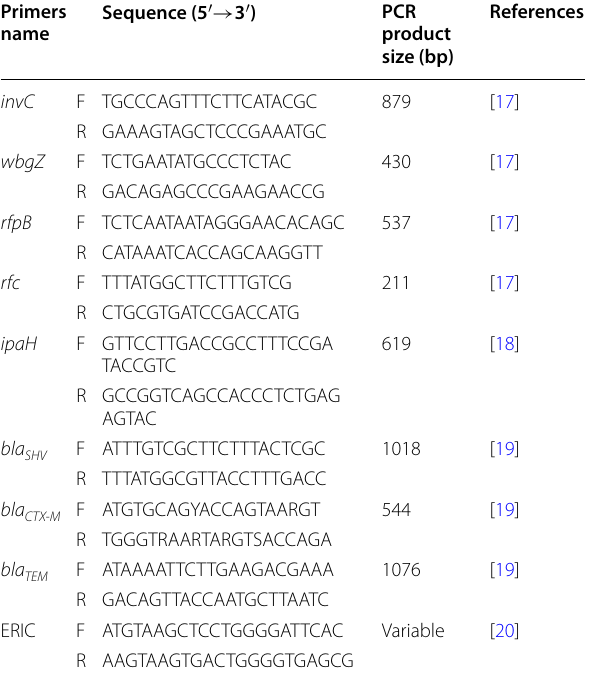
Table 1 Primers used for the detection of the Shigella species and ESBL encoding genes